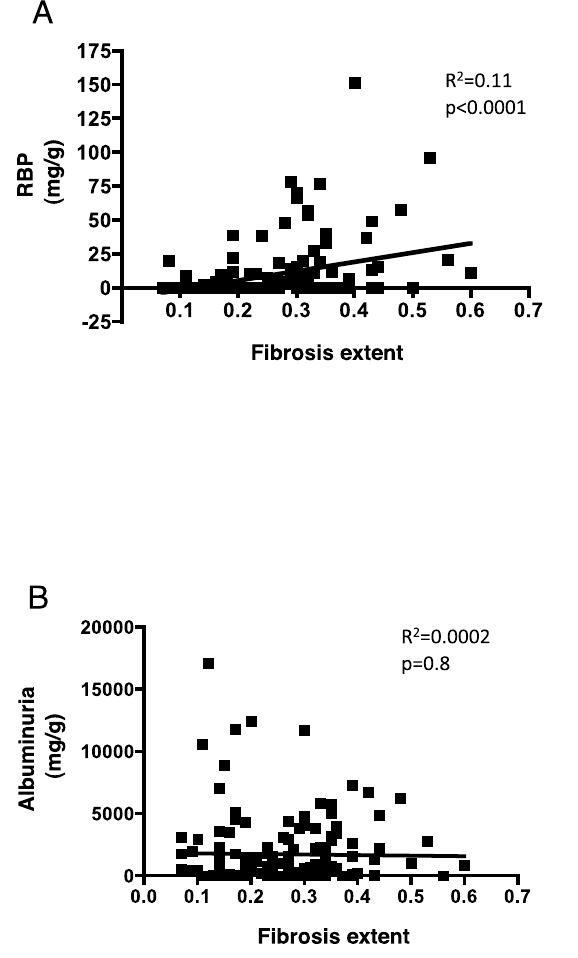
Figure 5. Correlation between proteinuria and the extent of interstitial fibrosis. A , B . Best-fit slope of the linear regression between RBP (A) and Alb (B) and extent of fibrosis extent.